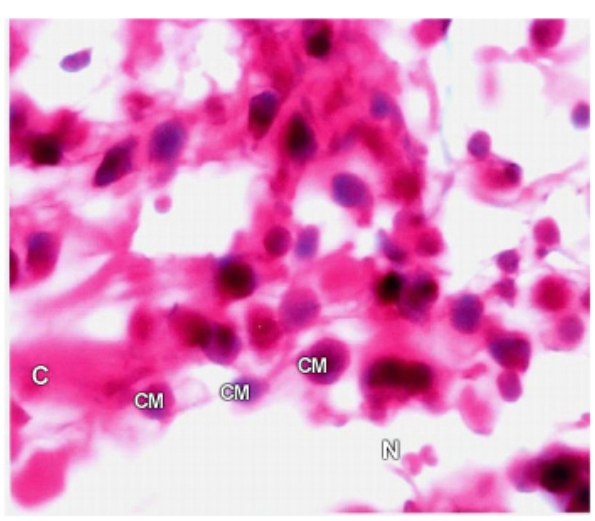
FIGURA 4 - Fotomicrografia mostrando a intensidade da reação inflamatória crônica no 7º dia de P.O. animal do grupo GE7D (coloração HE, aumento de 100x). Nota: C = colágeno. CM = Células